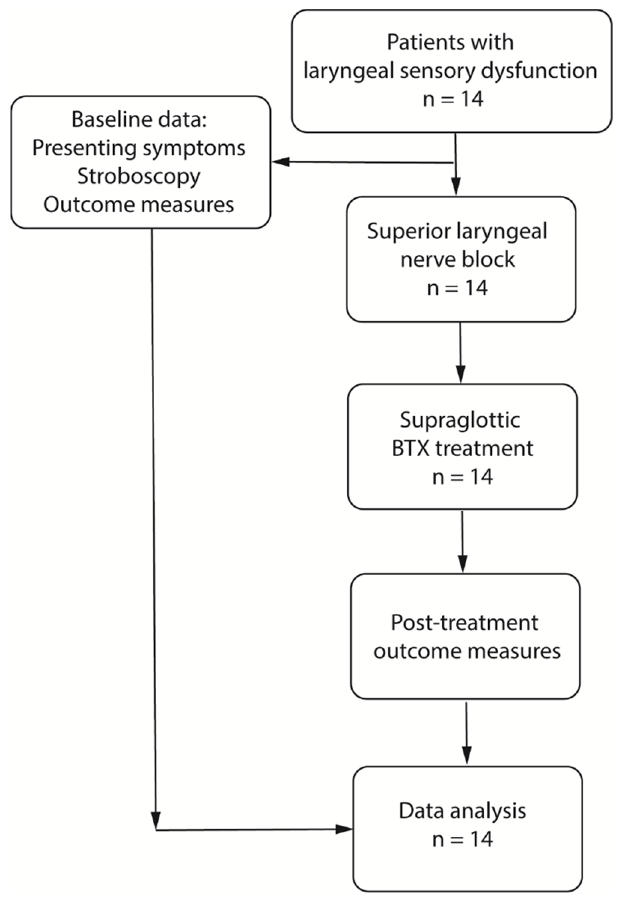
Figure 1. Flowchart of study protocols. Table 2. Characteristics of the treatment cohort. NM, neuromodulator; SLN, superior laryngeal nerve; Gaba, gabapentin; PR, partial response; Ami, amitriptyline; NR, no response; URTI, upper respiratory tract infection; NS, nonsmoker, FS, former